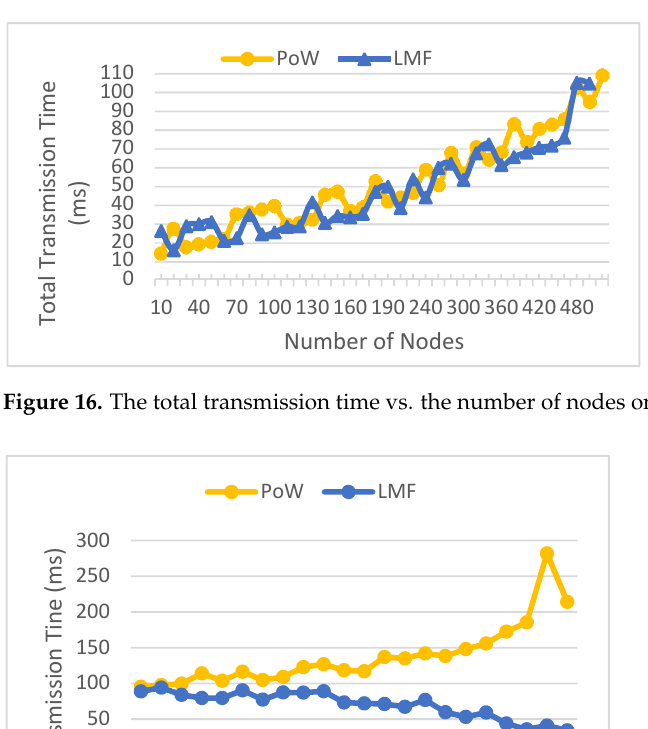
Figure 16. The total transmission time vs. the number of nodes on the PoW and LMF models.